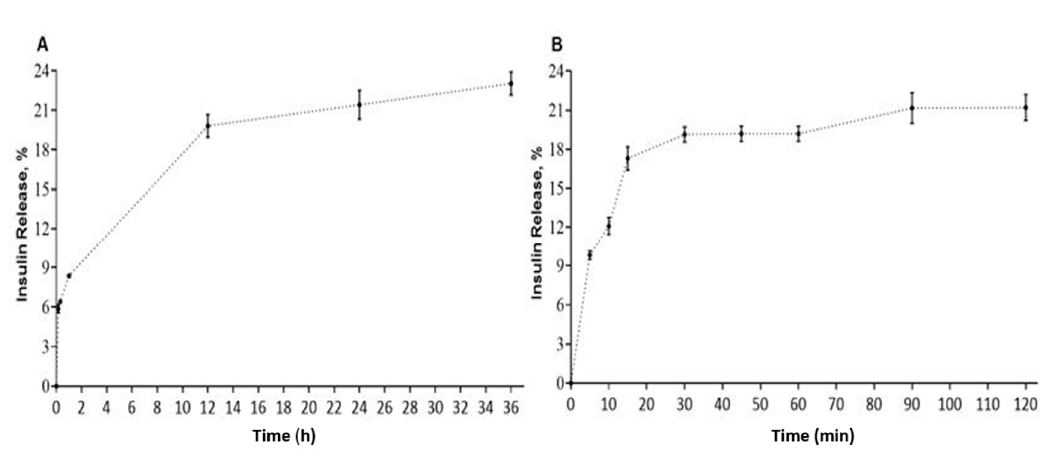
Figure 1. SMA-insulin micelles release rate. ( A ) In vitro release of insulin from SMA-insulin was assessed over 36 h, at pH 7.4, using a dialysis method. ( B ) In vitro release of insulin from SMA-insulin in SGF at pH 1.2 over 120 min using a dialysis method. Absorbance was measured at 214 nm.